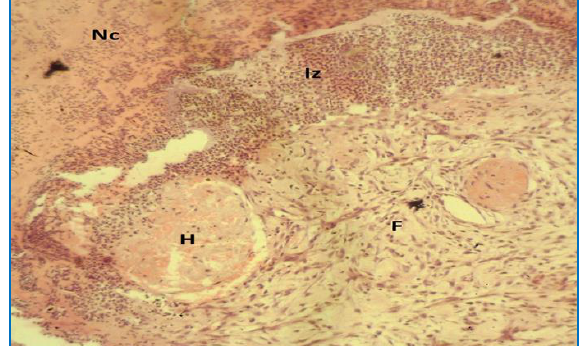
Figure, 8: Section of skin (7 days post treatment with pericardial craft) shows necrotized cells (Nc), inflammatory zone (Iz), fibrosis at the underlying dermis (F) and hemorrhage (H) H and E, 100x.